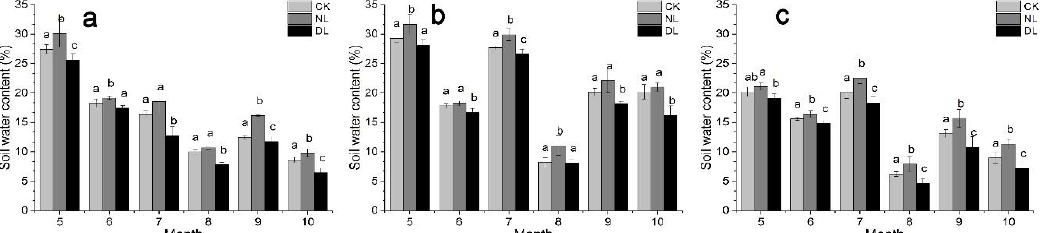
Figure 4. The monthly pattern of soil water content (at 10 cm depth) under litter manipulation during the study period (May to October in 2018) in different-aged Betula platyphylla forests of the permafrost region, Northeast China. Stand ages included 25 ( a ), 40 ( b ) and 61 ( c ). Litter manipulation included NL (no-litter), DL (double litter) and CK (control litter) in each stand. Lowercase letters represent significant differences under the same month and varied litter manipulation ( p < 0.05). Error bars indicate the standard deviation ( n = 9).